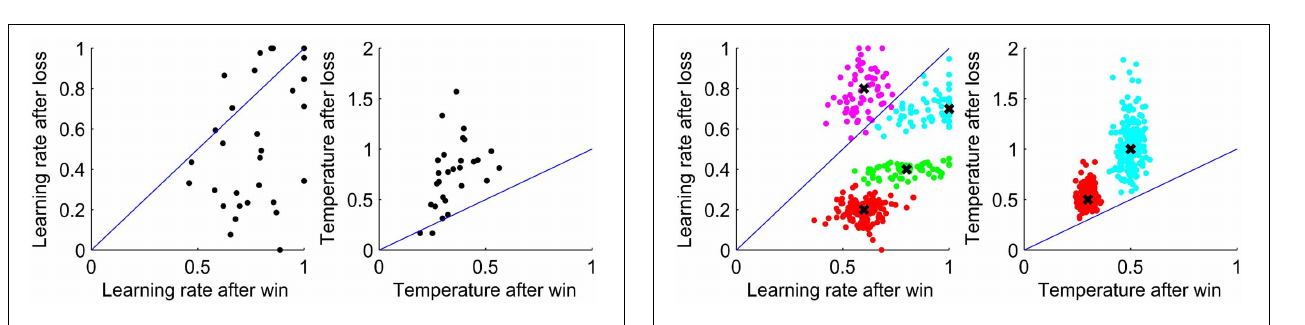
FIGURE 4 | Values of the fit parameters after a win and after a loss for each participant for the WL model. Left: Learning rate. Right: Temperature. In each plot, a line is shown to indicate equality of the fit parameters after a win and after a loss.